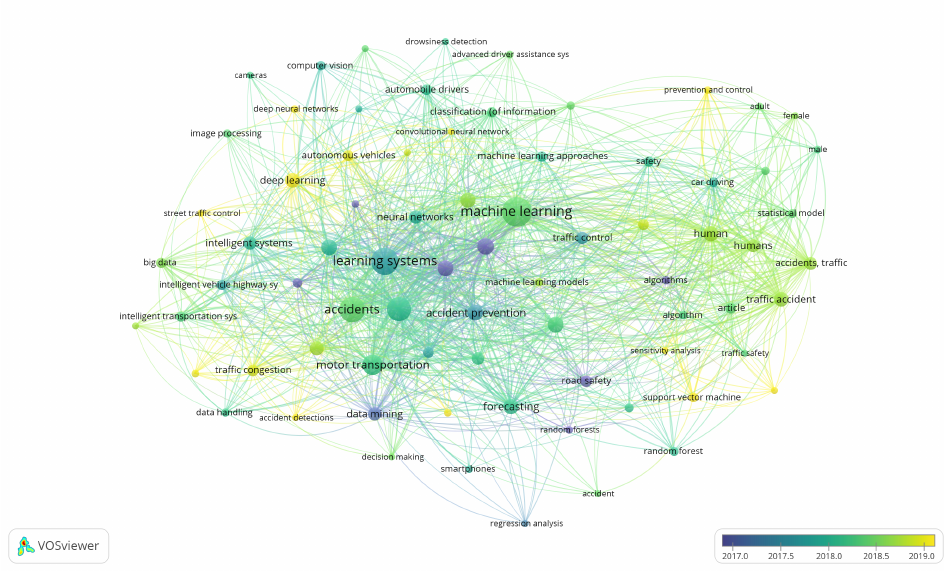
Figure 4. Keywords related to road accidents approached from a ML perspective.